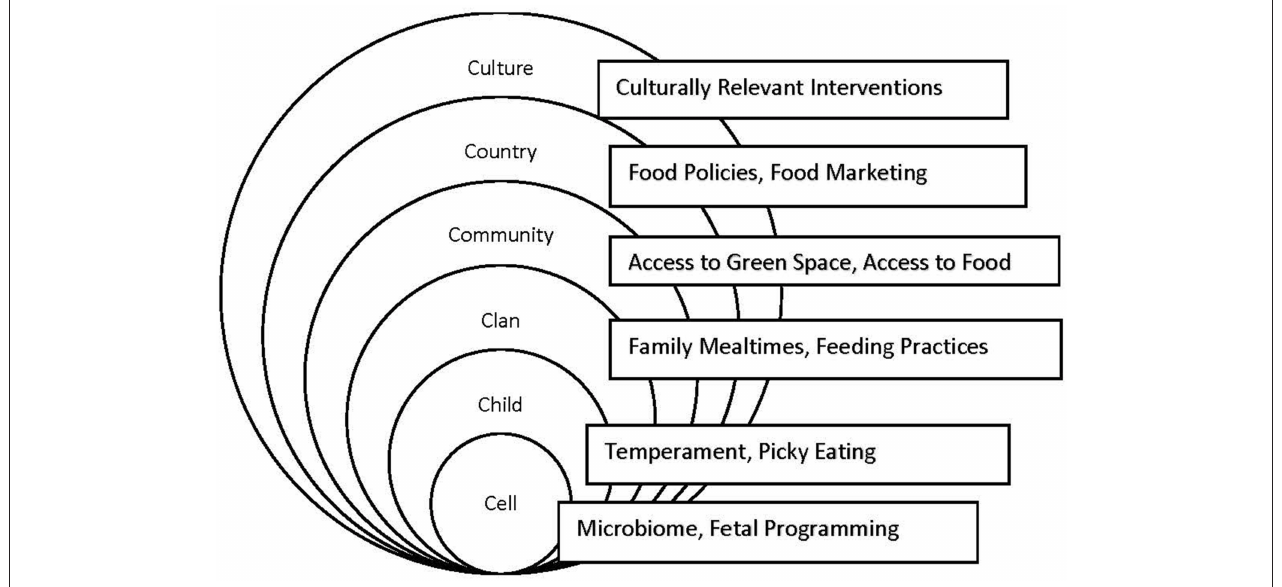
FIGURE 1 | Six C’s theoretical model that guided